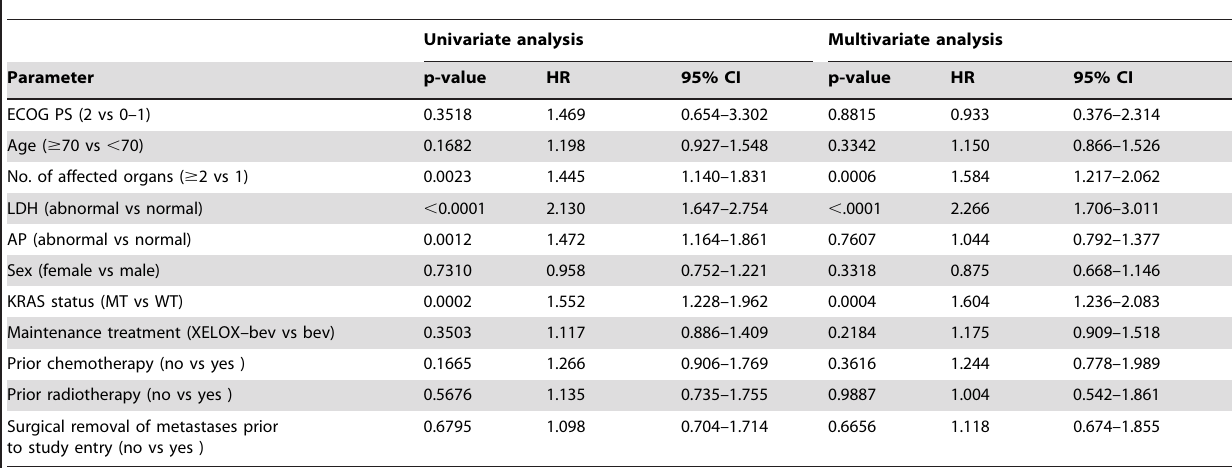
Table 4. Univariate and multivariate analyses of overall